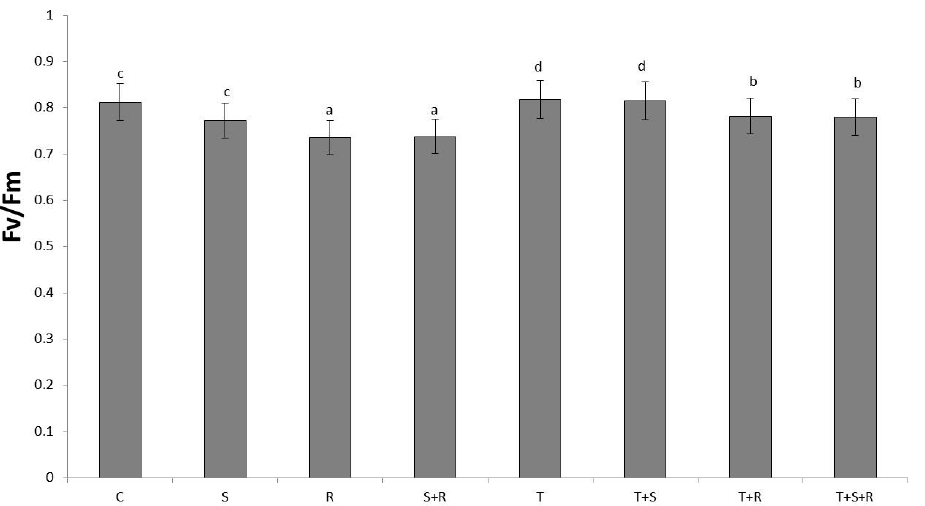
Figure 4. The effect of T. citrinoviride on Fv/Fm (PSII efficiency) in the leaves of strawberry which were subjected to abiotic stress (40 mM NaCl) and biotic stress (R. solani) either separately or in combination. Different letters indicates significant differences between treatments ( p < 0.05). C, control; S, NaCl-treated; R, R. solani -infected; S + R, Salt stress + R. solani; T, T. citrinoviride- treated; T + S, T. citrinoviride + NaCl; T + R, T. citrinoviride + R. solani ; T + S + R, T. citrinoviride + NaCl + R. solani .